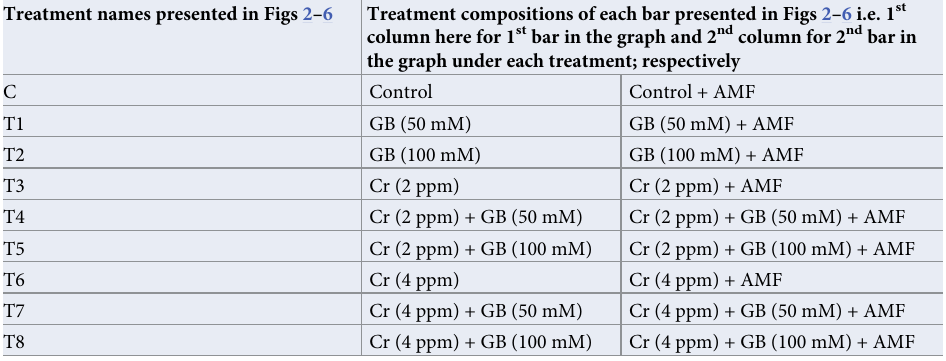
Table 2. Treatments details of AMF and GB provided in the soil before the